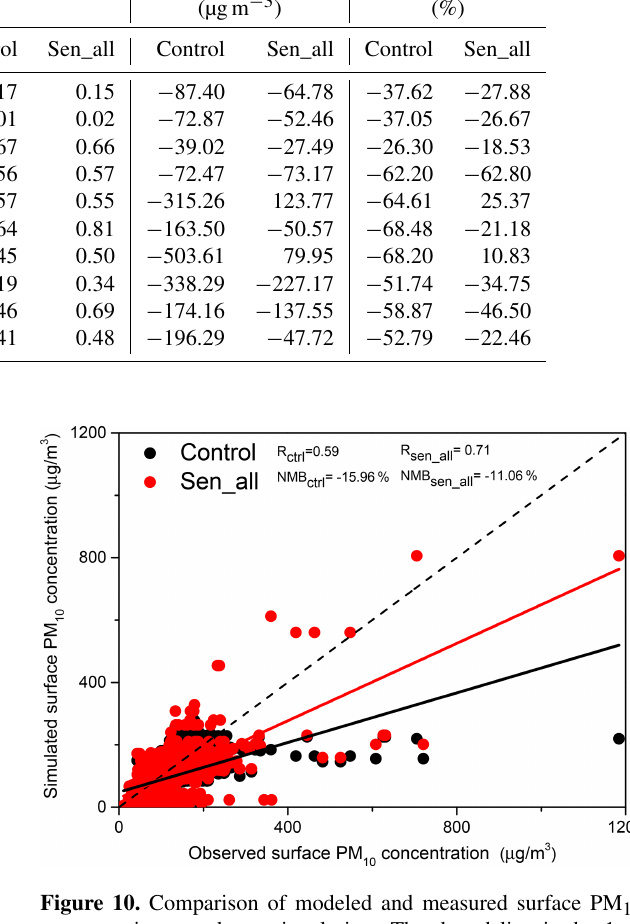
Table 4. Statistics for observed and simulated (control and Sen_all) surface PM 10 concentrations at selected sites. Sites Obs. mean